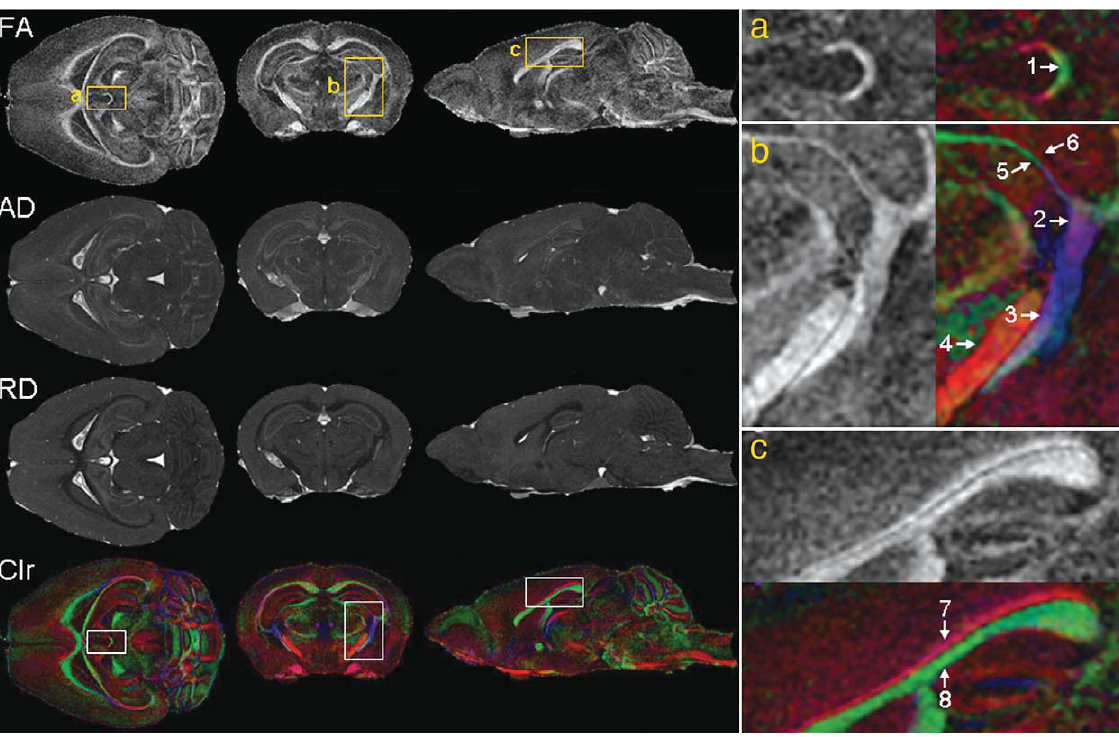
Fig. 13. Diffusion tensor imaging (DTI) provides rich information on white matter structures, connectivity patterns, as well as the integrity of these connections in the mouse brain. Among the parameters calculated from DTI are: FA (fractional anisotropy), AD (axial diffusivity), RD (radial diffusivity), and Clr (color-coded orientation map of the primary eigenvector. Green: left-to-right; red: rostral-to-caudal; blue: dorsal- to-ventral). The right column shows magnified views that correspond to the regions specified by the rectangles (a, b, and c) in the left column. Arrows indicate structures that are better discerned using directional information on the colormap: 1. Habenular commissure; 2. Fimbria; 3. Optic tract; 4. Cerebral peduncle; 5. Thin branch of optic tract adjacent to 6. Thin branch of fimbria; 7. Cingulum (rostro-caudal orientation); 8 Corpus callosum (medial to lateral orientation). Reproduced with permission from